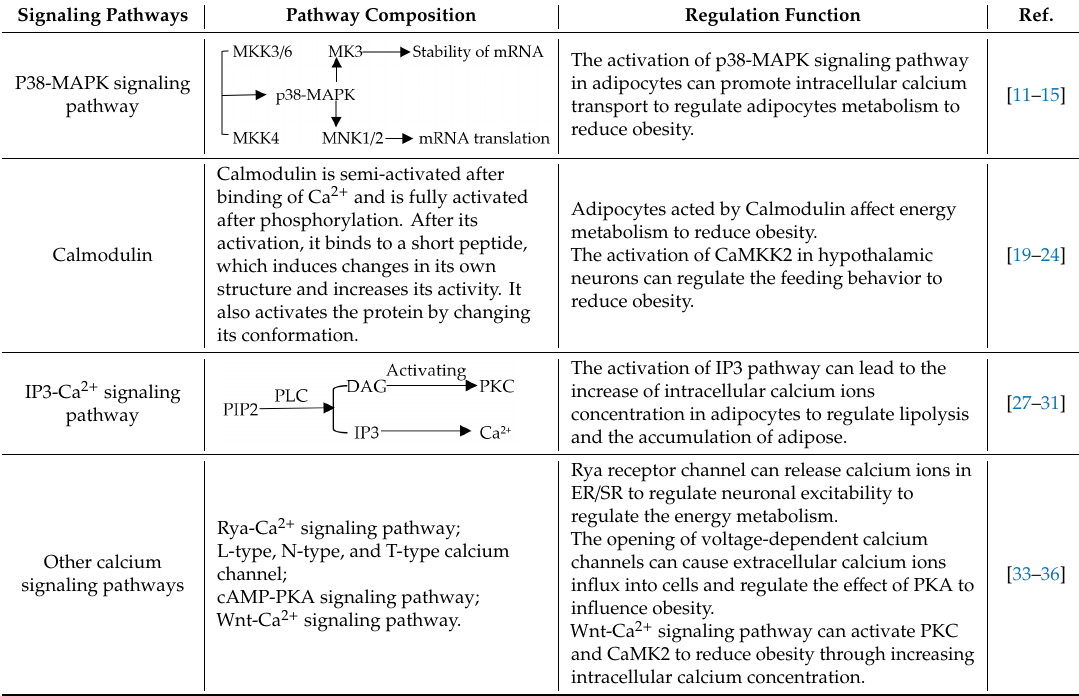
Table 1. Brief introduction of calcium signaling pathways.